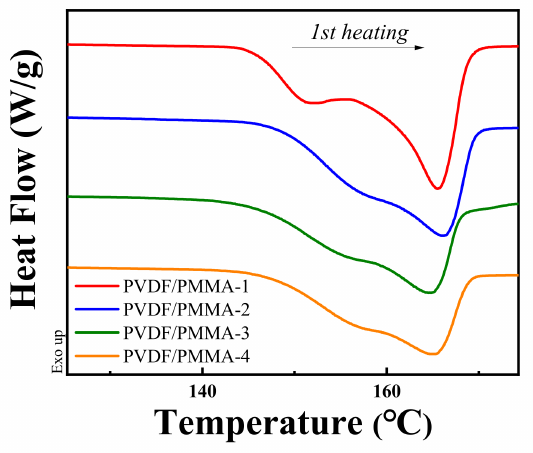
Figure 5. DSC curves for the first heating of PVDF/PMMA with different M w of PMMA after complete isothermal crystallization.